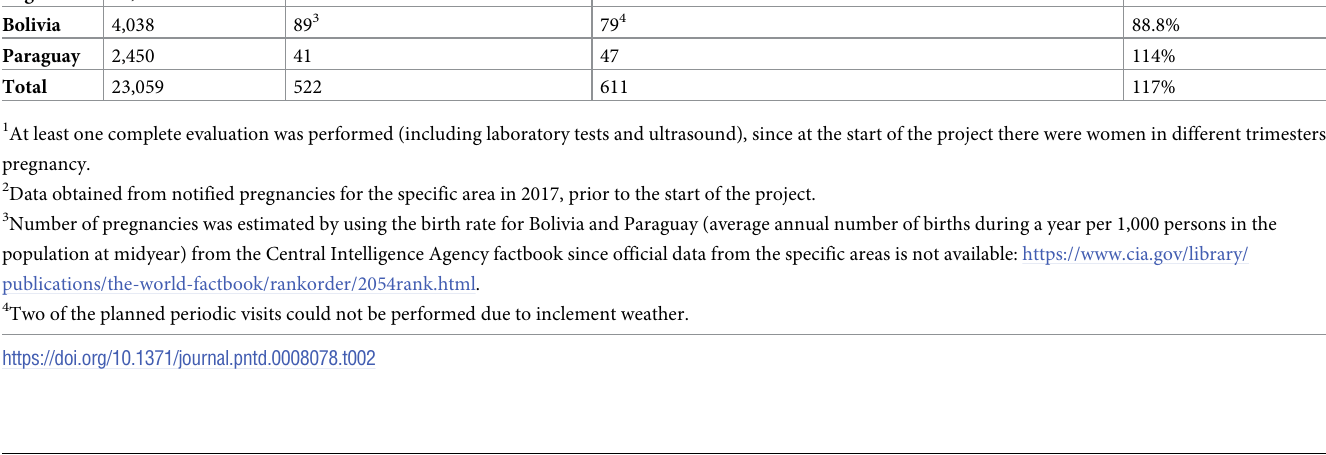
Table 2. Preliminary data from the first year of implementation.